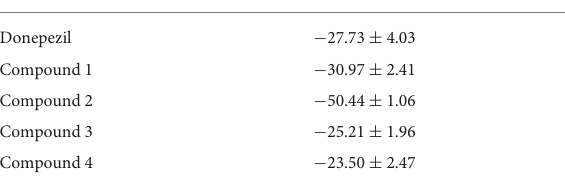
TABLE 3 Variations of the total Gibbs free energy of the molecules analyzed in the study of molecular